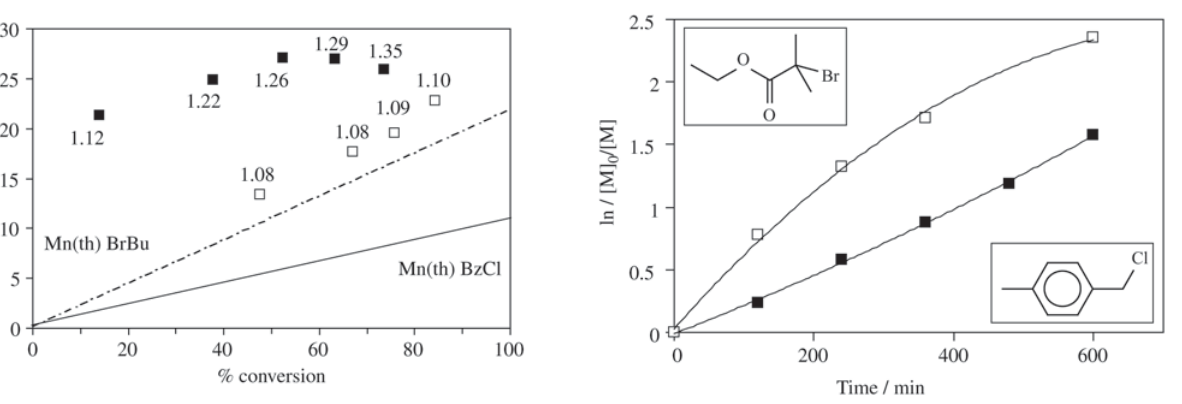
Figure 5. Semi-logarithmic kinetic plot for the synthesis of linear Figure 4. Dependence of M on monomer conversion of linear n PMMA initiated by 4-methylbenzyl chloride (BzCl) (filled) or PMMA initiated by 4-methylbenzyl chloride (BzCl) (filled) or ethyl-2-bromoisobutyrate (BrBu) (open). Lines are used only to ethyl-2-bromoisobutyrate (BrBu) (open). Lines represent the theo- guide the eye. [BzCl] = 2.92 mM, [CuCl] = 23.4 mM, retical M for eachh study and numbers are PDI values according n MMA:BzCl = 100; [BrBu] = 1.46 mM, [CuCl] = 11.7 mM, to GPC. [BzCl] = 2.92 mM, [CuCl] = 23.4 mM, MMA:BzCl = 100; MMA:BrBu = 200. [BrBu] = 1.46 mM, [CuCl] = 11.7 mM, MMA:BrBu = 200.